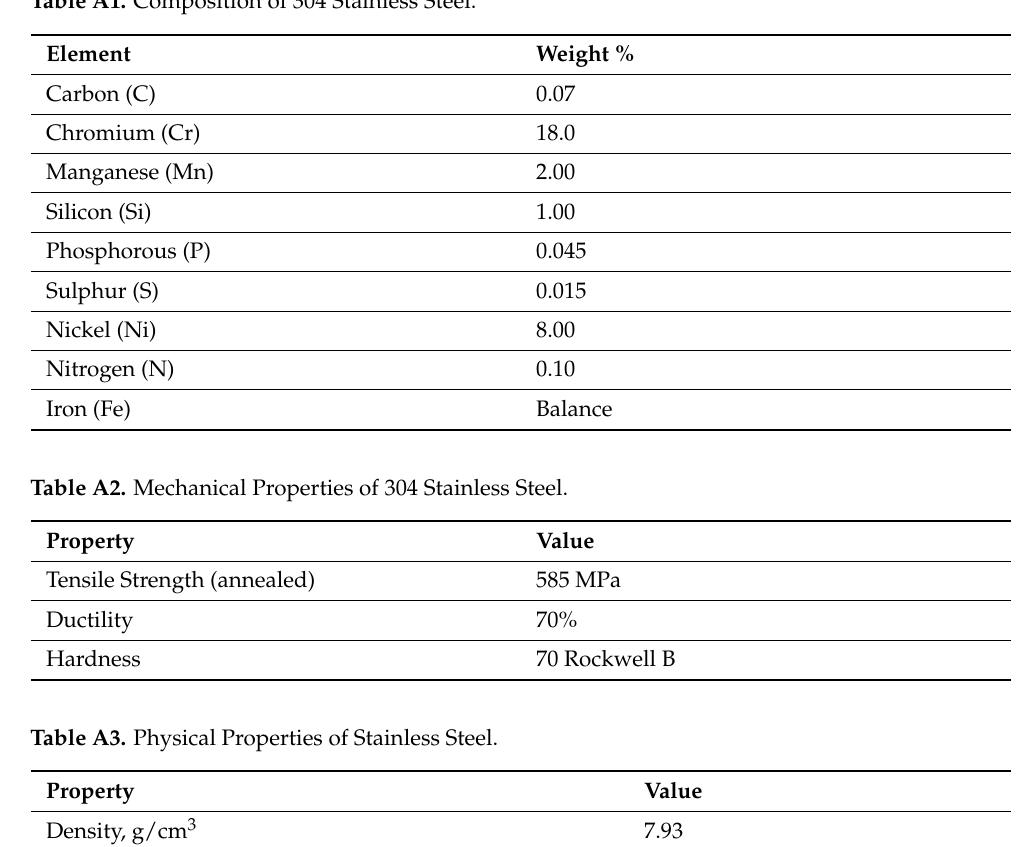
Table A1. Composition of 304 Stainless Steel.